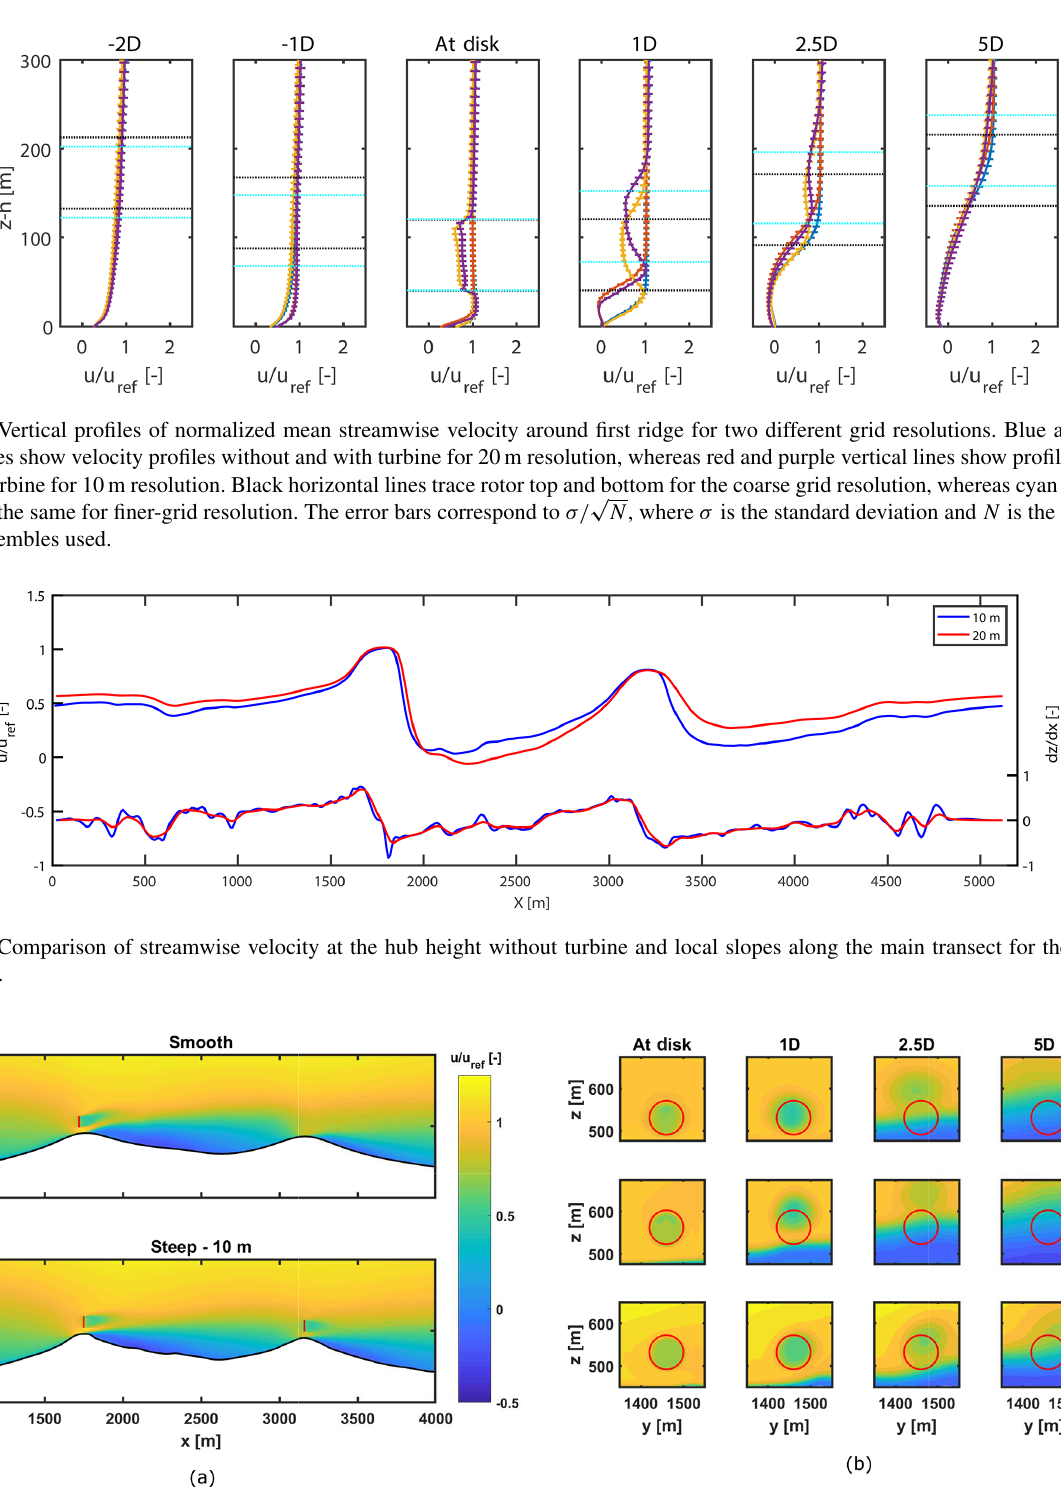
Figure 8. (a) Streamwise velocity profile for smooth and steep terrain; (b) wake development in the rotor plane at different downstream locations. First row: first turbine, smooth terrain – 20m resolution; second row: first turbine, steep terrain – 10m resolution; third row: second turbine, steep terrain – 10m resolution. Rotor position is highlighted by the red